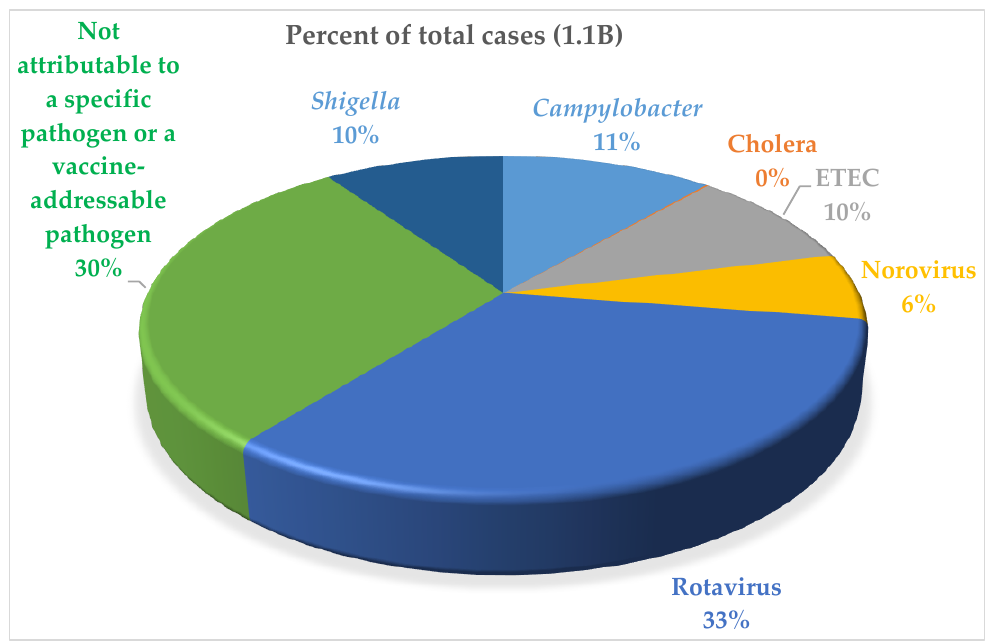
Figure 1. Percent of total cases of diarrheal disease caused by specific pathogens. Cholera shows as negligible in the chart because of the low number of cases compared with the other causes of enteric diseases shown. These are data for 2016 cited in [5].